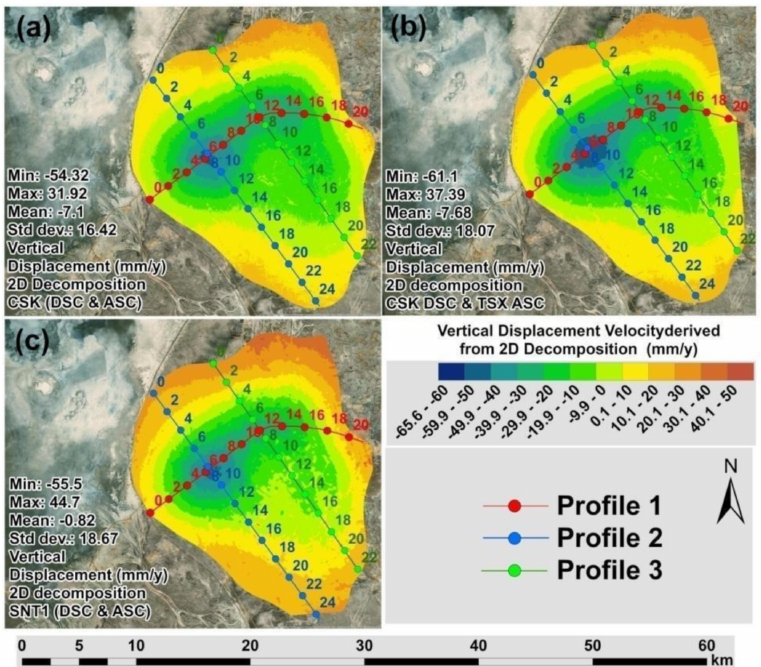
Figure 10. Maps with profiles of vertical displacement velocity (2018–2020) derived from 2D decom- positions of: ( a ) CSK DSC/CSK ASC Tracks; ( b ) CSK DSC/TSX ASC Tracks; ( c ) SNT1 DSC/SNT1 ASC